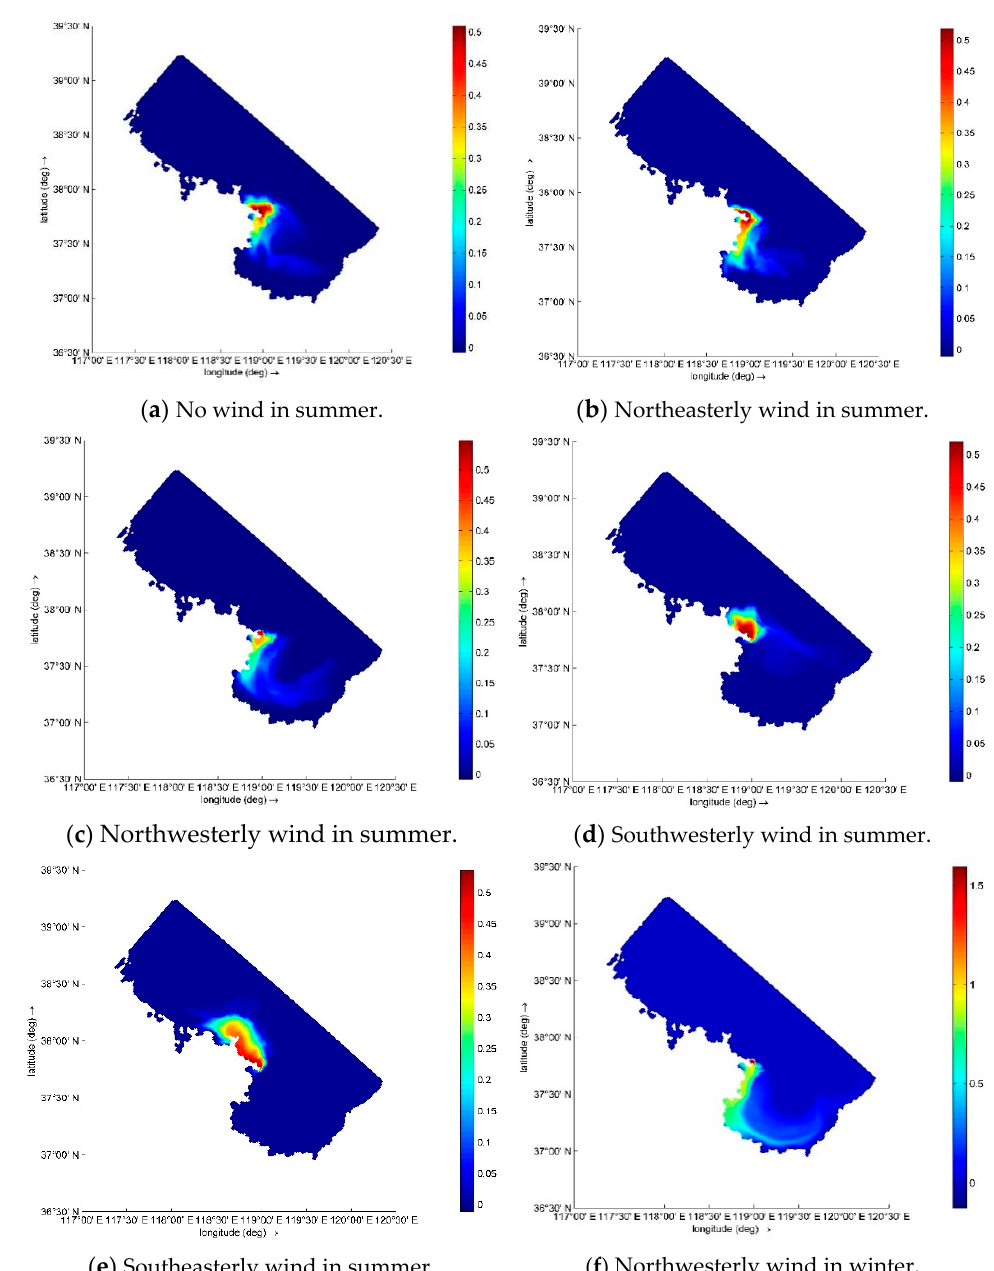
Figure 9. Suspended sediment diffusion in the Yellow River delta under no wind (a ), northeasterly wind ( b ), northwesterly wind ( c ), southwesterly wind ( d ), and southeasterly wind ( e ) in summer and northwesterly wind ( f ) in winter (unit: g/L).